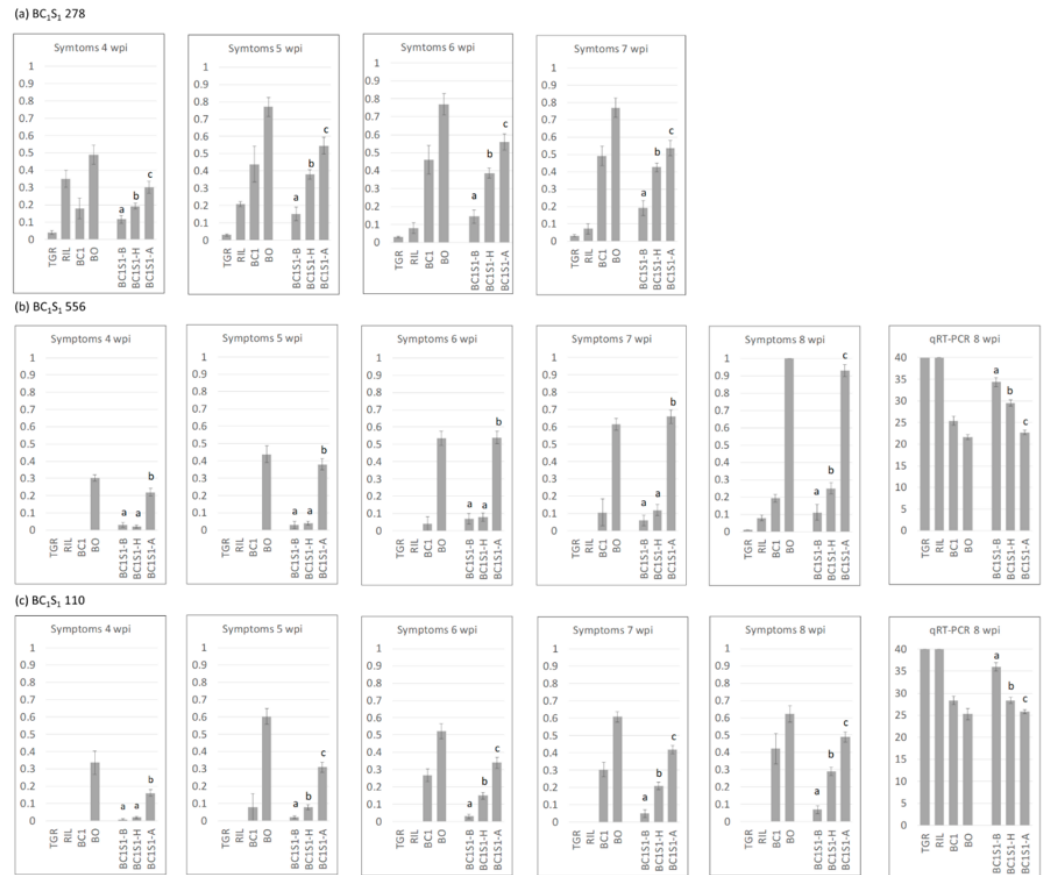
Figure 2. Average symptom score (percentage of leaves showing clear symptoms of CYSDV infection) for different evaluation dates (wpi: weeks post infection) and average Ct (cycle threshold) in the qRT-PCR carried out to detect CYSDV (when available). ( a ) BC 1 S 1 278; ( b ) BC 1 S 1 556; ( c ) BC 1 S 1 110. Genotypes are expressed as follows: TGR: TGR-1551; RIL: selected RIL, RIL278, 556, or 110; BC 1 : first backcross to 'Bola de Oro' of the selected RIL; BO: 'Bola de Oro'; BC 1 S 1 : selfing progeny from the BC 1 , classified according to the genotype for marker cysdv22 for RIL278 and marker cysdv63 for RILs 556 and 110, where BC 1 S 1 -B is homozygous for TGR-1551 allele, BC 1 S 1 -H is heterozygous, and BC 1 S 1 -A is homozygous for ‘Bola de Oro’ allele. Bars represent standard error. Different letters in the same evaluation date indicate significant differences among genotypes ( p < 0.05, LSD test).